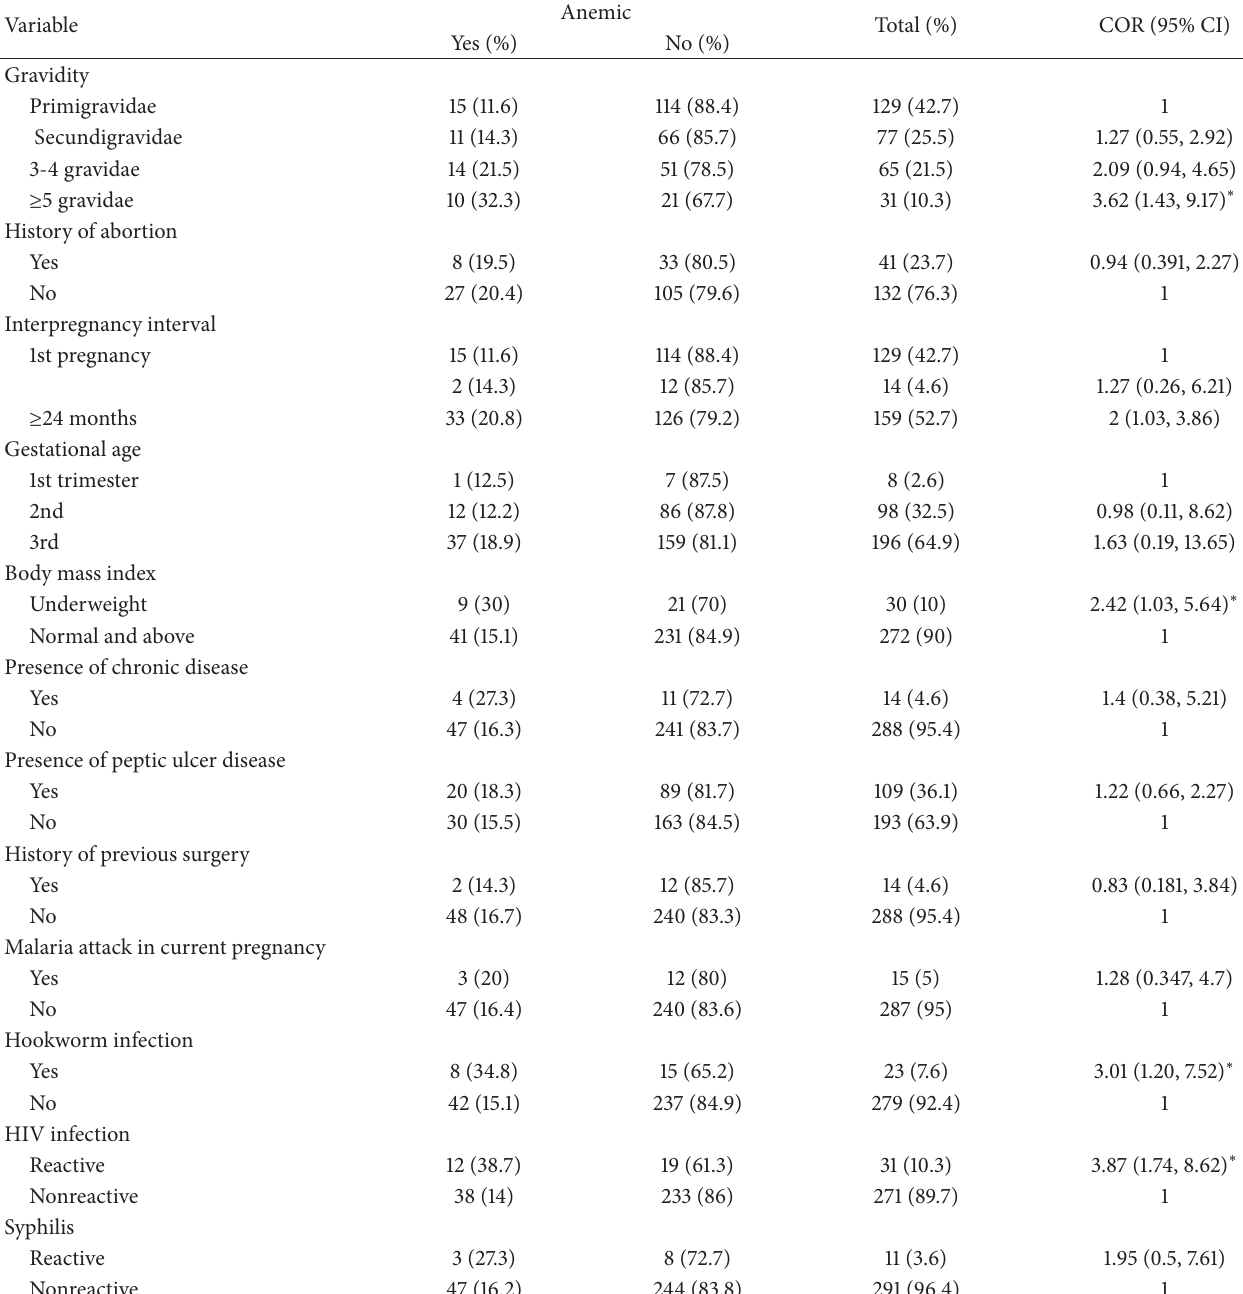
Table 2: The prevalence of anemia according to the obstetrics and medical factors ( 𝑛 = 302